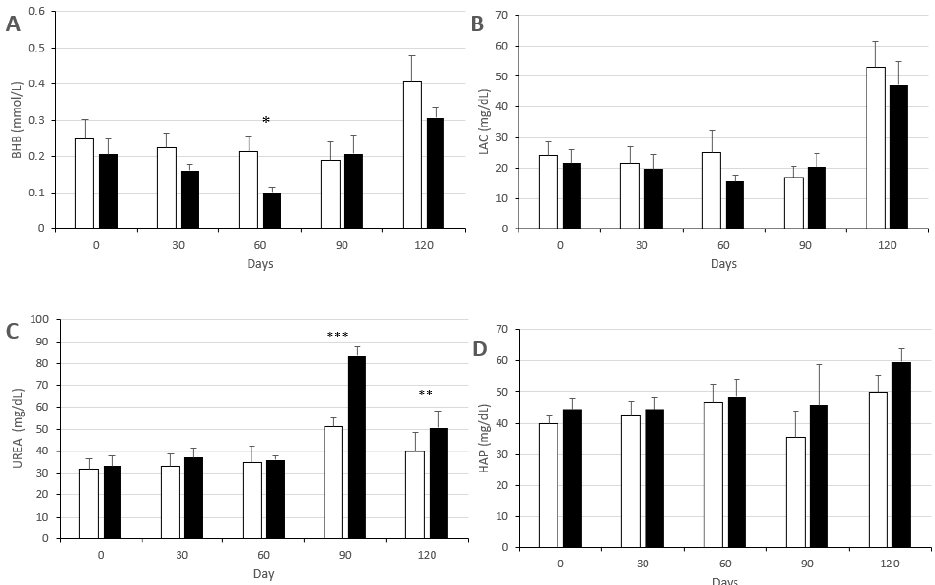
Figure 4. Mean values ( ± S.E.M.), over time of study, in mean plasma concentrations ( ± S.E.M.) for metabolic parameters in sows used as controls (group CON; white bars) or treated with two doses of Vacsincel ® for inducing ovarian inactivity (group MEN; black bars); BHB: β -hydroxybutyrate ( A ); LAC: lactate ( B ); UREA: urea ( C ) HAP: haptoglobin ( D ). Asterisks indicate significant differences between groups (* p < 0.05; ** p < 0.01; *** p < 0.005).